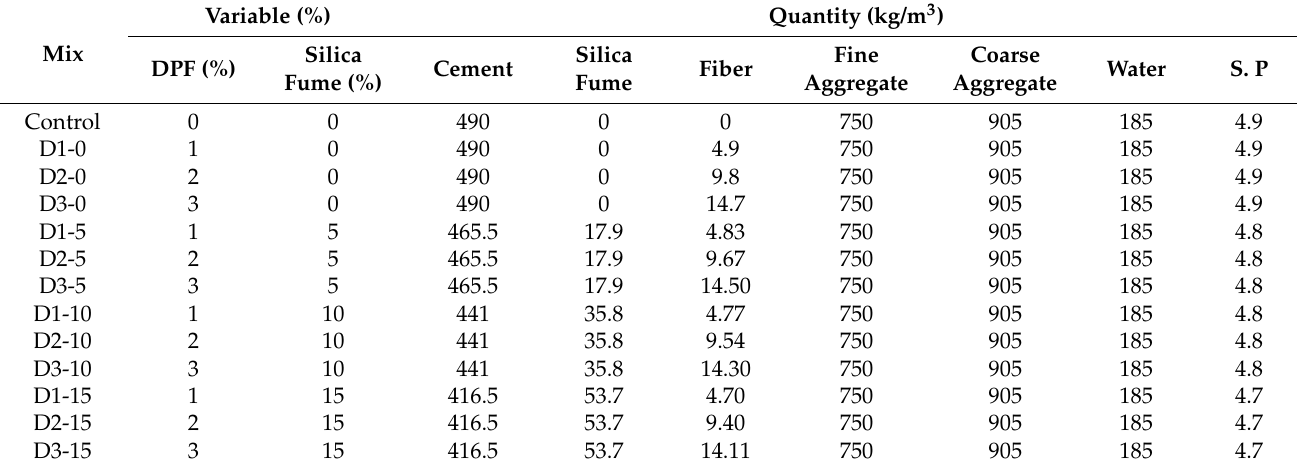
Table 3. Mix proportions and constituent